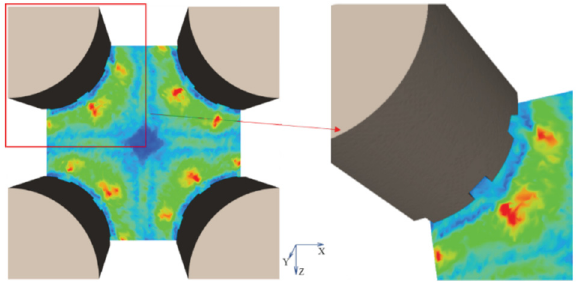
Fig. 8. Distribution of the erosion location of distribution